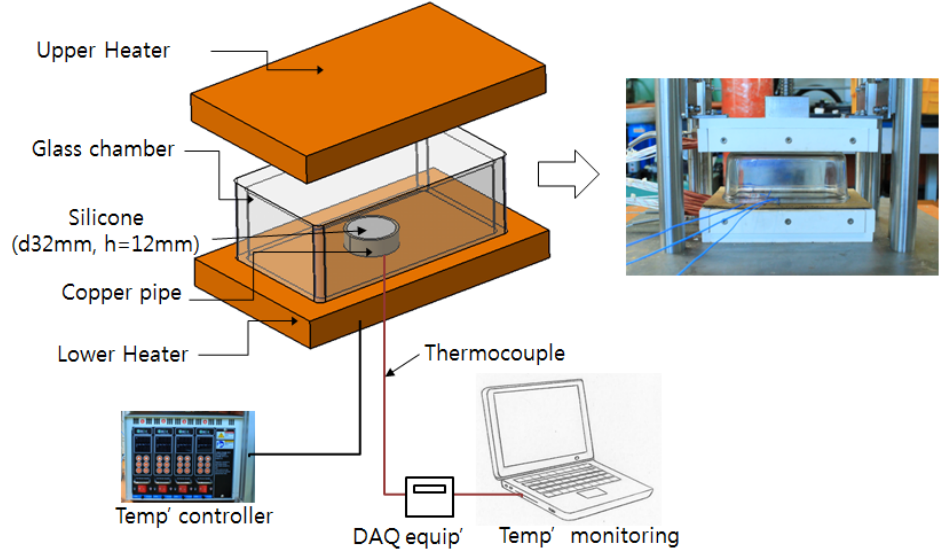
Figure 1. Experimental set-up for silicone